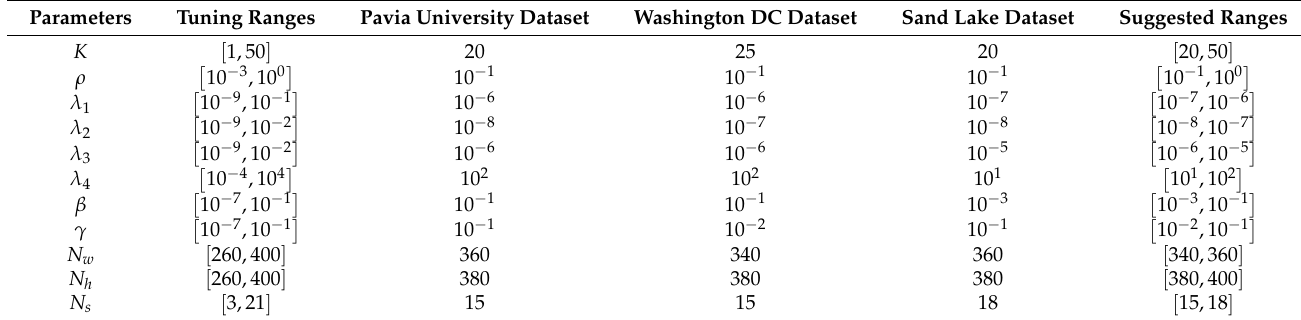
Table 1. Discussion of the main parameters.